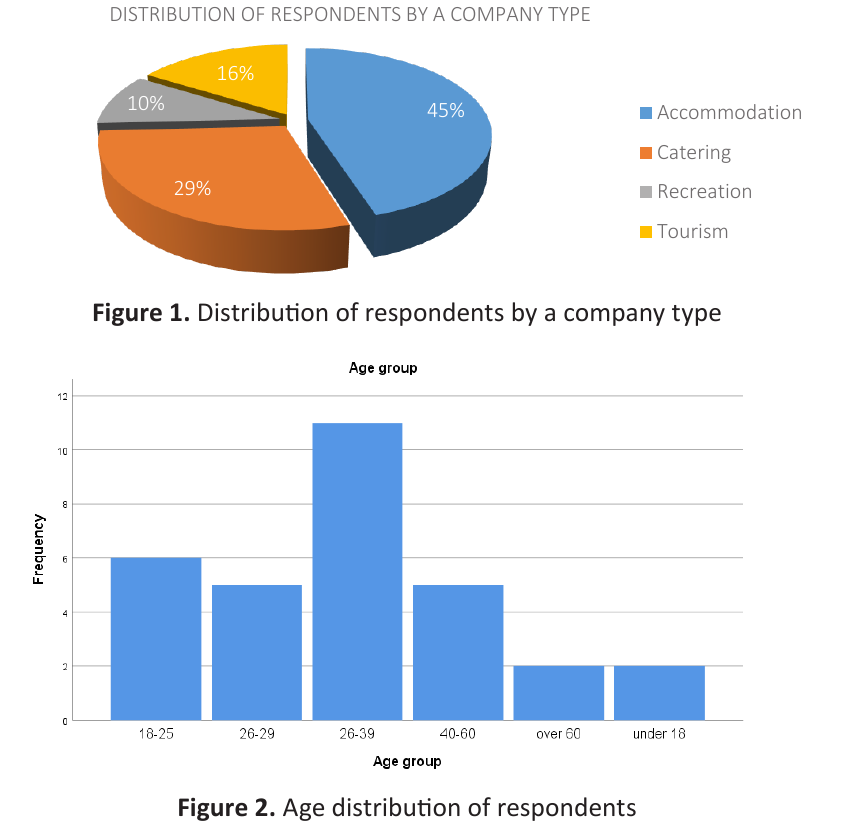
Figure 2. Age distribution of